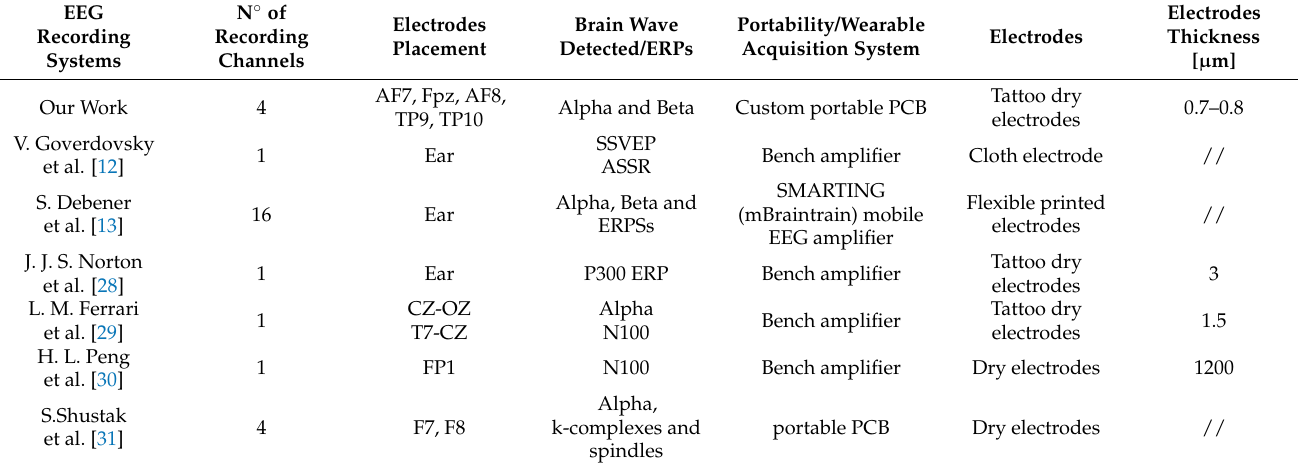
Table 1. Comparison between different EEG systems based on bioelectronic